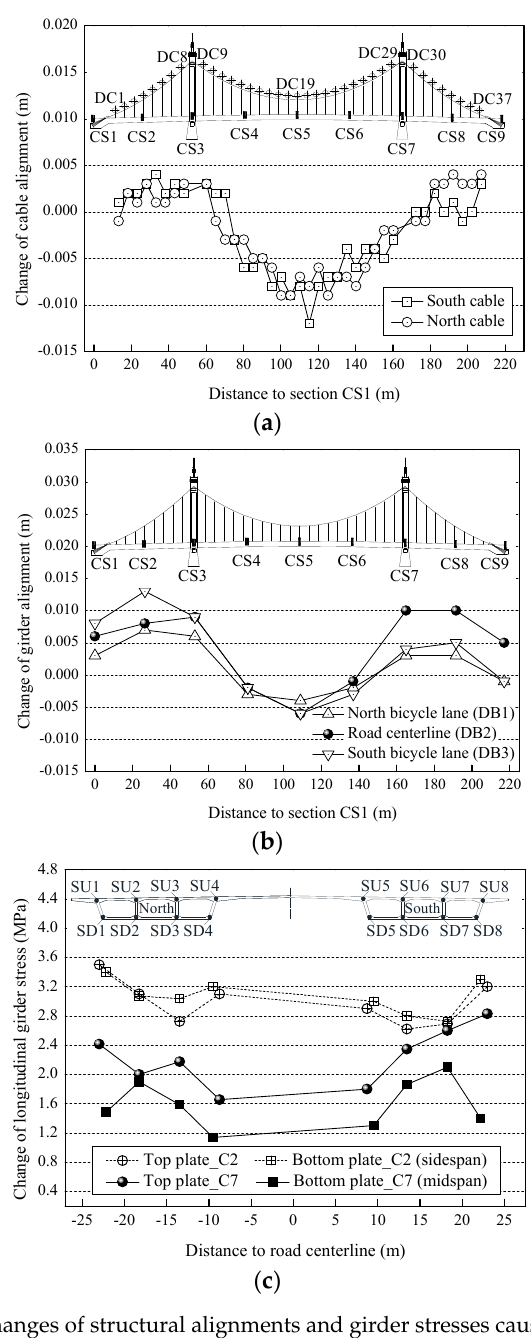
Figure 11. Measured changes of structural alignments and girder stresses caused by seasonal ambient warming from 2 °C to 28 °C: ( a ) Cable alignment; ( b ) Girder alignment; and ( c ) Girder stress.